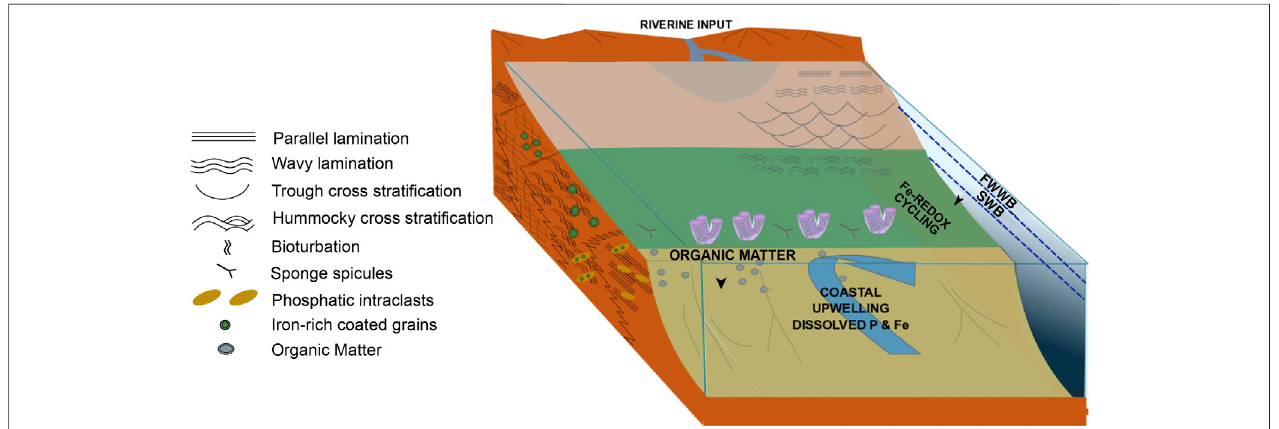
FIGURE12| DepositionalmodelforWelshBasinironstone.CoastalupwellingprovidesmicronutrientsFeandPtotheshelfstimulatingprimaryproductivityandthe food source of fi lter feedingsponges on the shelf. Fe-redox cycling on the shelf concentratesthe nutrientsin the sediment, with redox conditions and hydrodynamics as the primary control of facies distributions. A riverine source for terrigenous clastics is inferred. FWWB, fair-weather wave base; SWB, storm wave base. Modi fi ed from Todd et al. (2019).